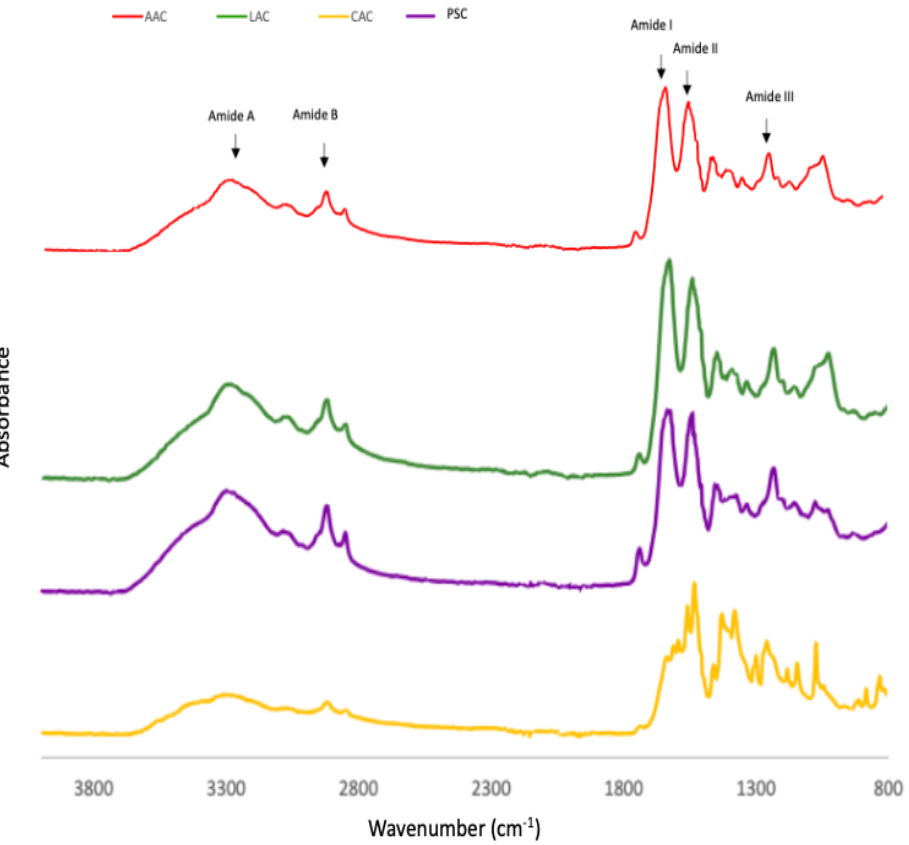
Figure 3. FTIR patterns of purple-spotted bigeye snapper skin collagen extracted with different acids and pepsin. AAC: Acetic acid collagen; LAC: Lactic acid collagen; CAC: Citric acid collagen; PSC: Pepsin soluble collagen.